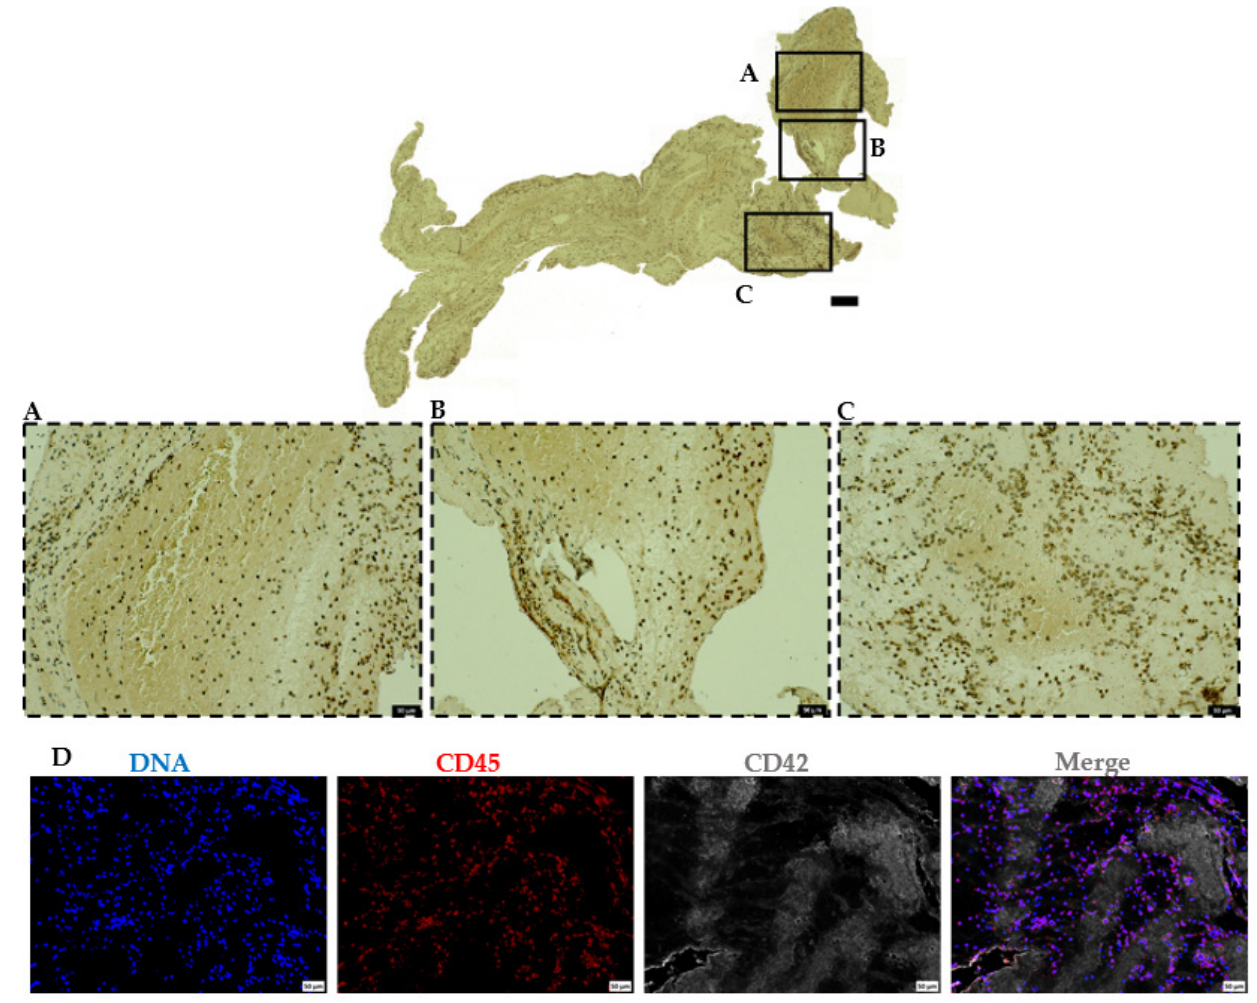
Figure 6. Abundant leukocyte accumulation mainly at the interface between platelet-rich and RBC-rich areas. ( A – C ) Immunohistochemical staining of retrieved AIS patient thrombi to visualize leukocytes using CD45 antibody (upper panel). Higher magnification of the representative staining is shown in inserts (lower panels). Scale bars: 200 μ m (top panel) and 50 μ m (lower panels). ( D ) Representative ischemic stroke patient thrombi stained for leukocytes (CD45, red), platelets (CD42b, grey), and DNA (DAPI, blue). Scale bars: 50 μ m. To determine the nature and source of this citrullinated histone-decorated nuclear material, immunocytochemistry using NET-marker H3Cit and neutrophil-specific markers neutrophil elastase, (NE) and myeloperoxidase (MPO) was performed; since neutrophils are the most abundant leukocytes and are specifically involved in NET formation